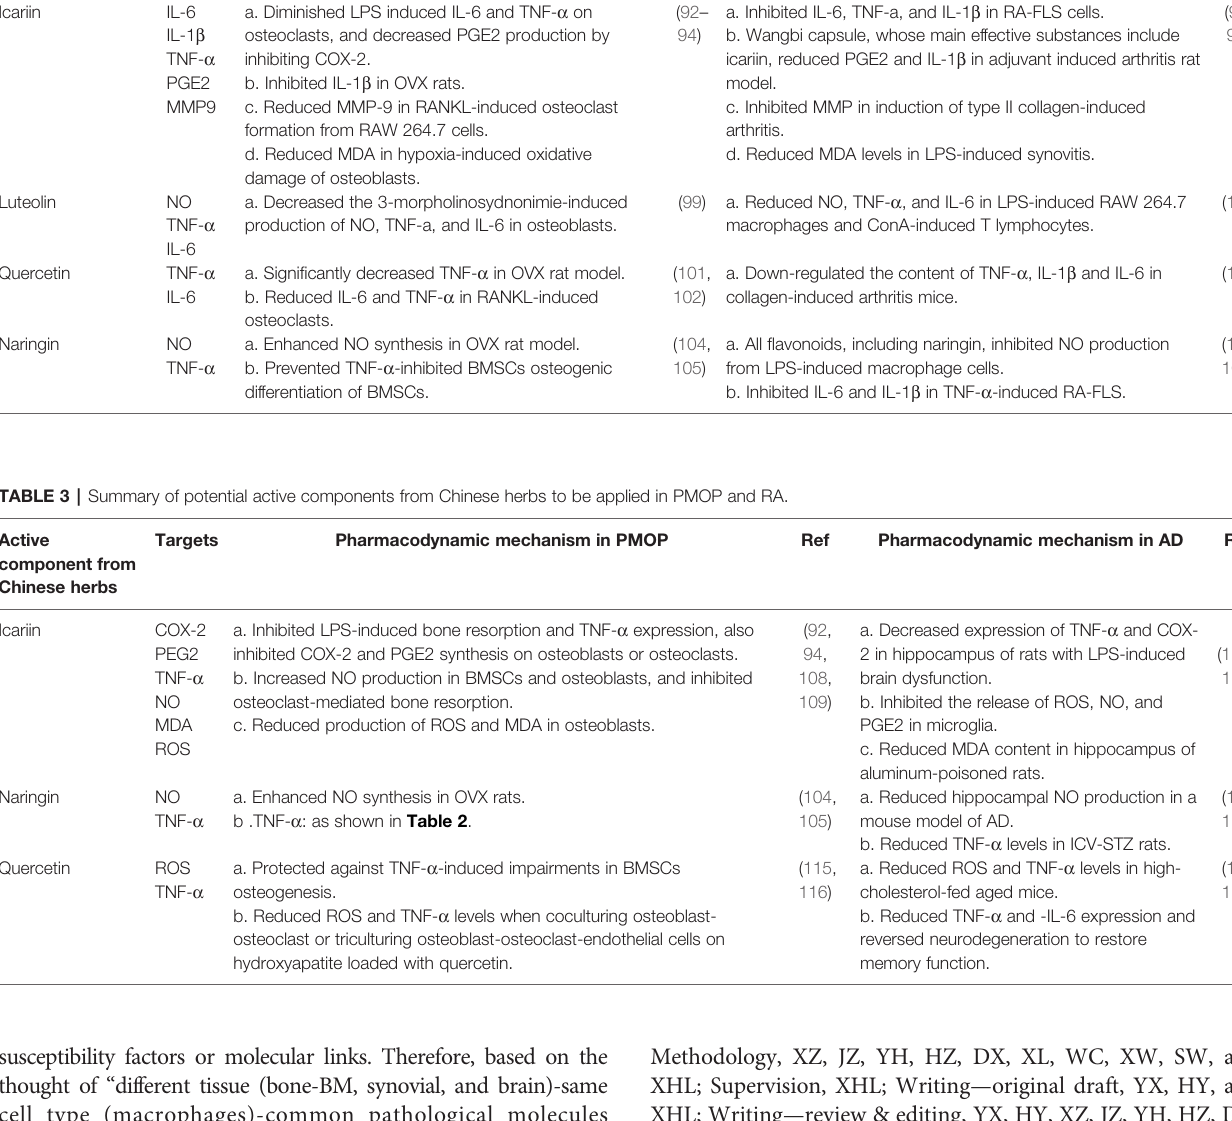
TABLE 2 | Summary of potential active components from Chinese herbs to be applied in PMOP and RA. Active component from Chinese herbs